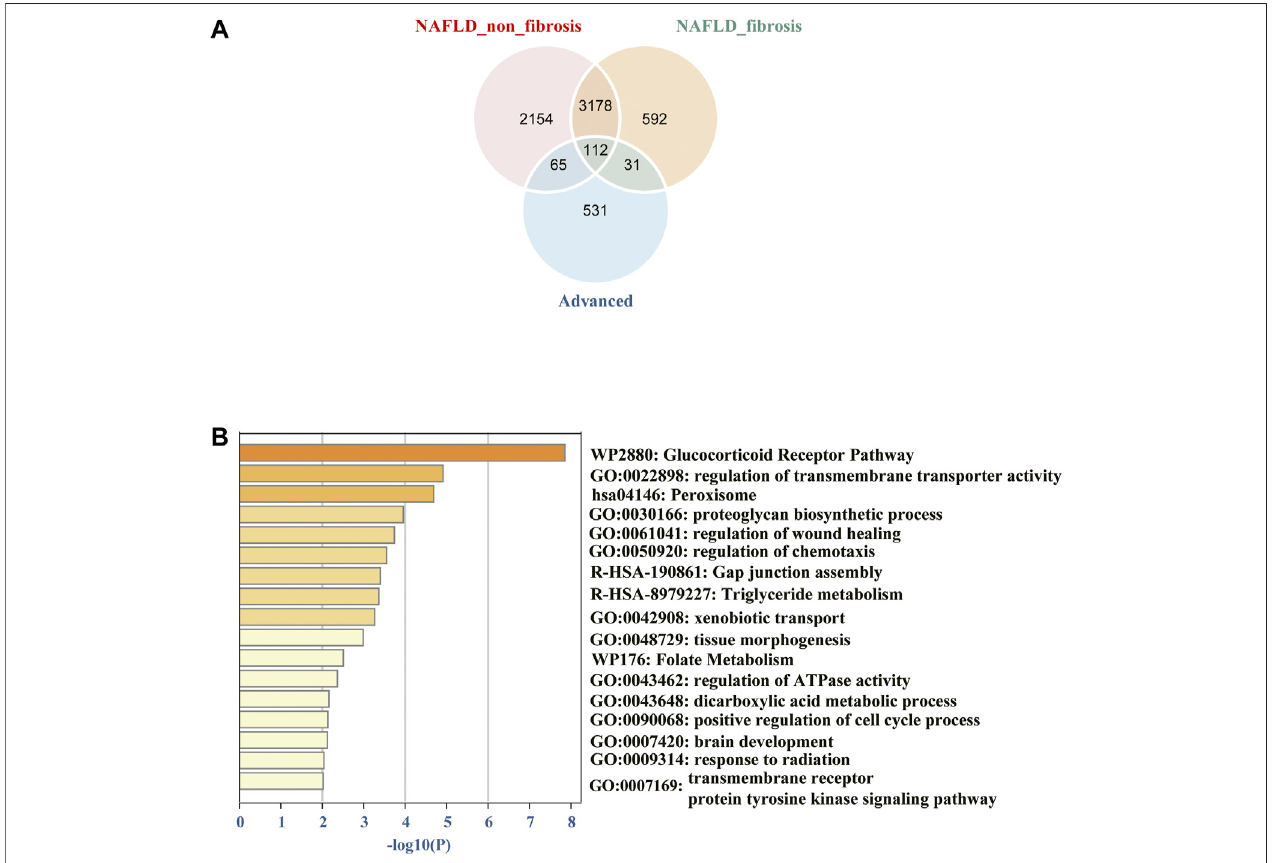
FIGURE 3 | (A) Venn diagram of common differentially expressed genes from different groups among the two datasets. (B) The 112 common DEGs were carried outenrichmentanalysisbyusingMetascape.Thebrowncolumnrepresentsthe – log10(p-value)oftheterm.Theresultshowedthattheglucocorticoidreceptorpathway, regulation of transmembrane transporter activity, peroxisome, proteoglycan biosynthetic process, regulation of wound healing, regulation of chemotaxis, etc. were the signi fi cantly enriched GO or pathways.